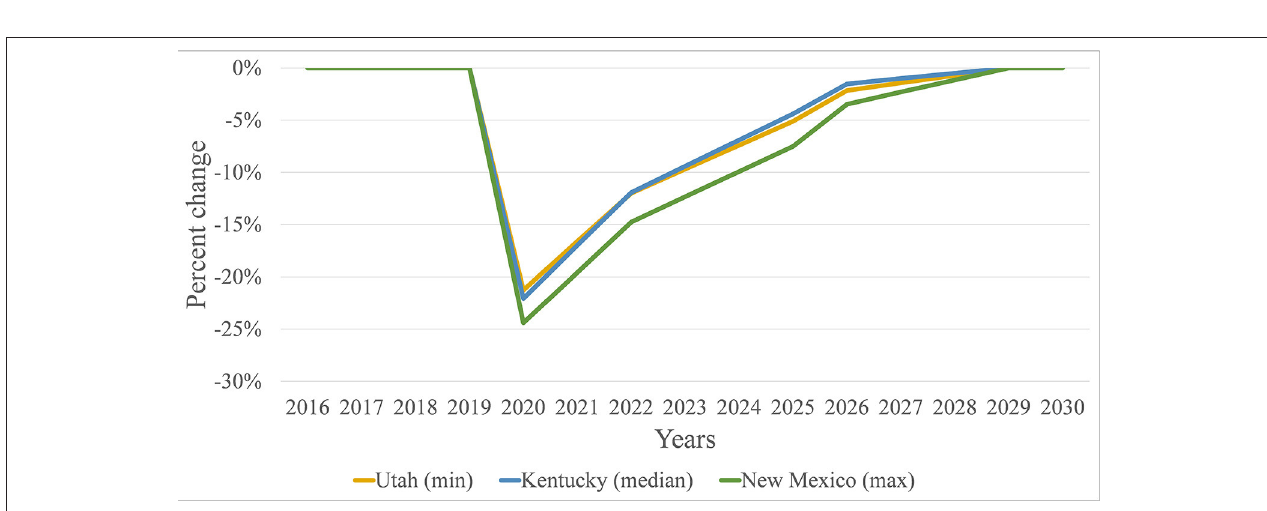
FIGURE 5 | US-FEAST state-level cow meat production changes in the BSE outbreak scenario compared to the baseline scenario.